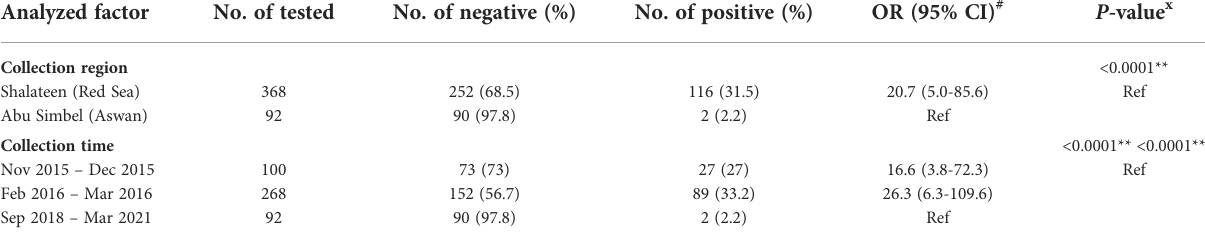
TABLE 2 Factors in fl uencing anti- Toxoplasma gondii antibodies in camels in Egypt. Analyzed